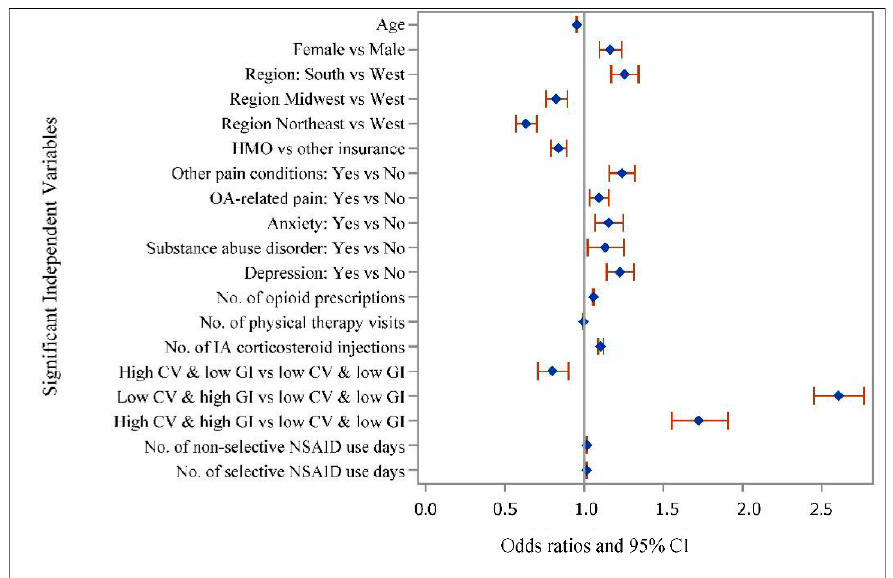
Figure 2. Unadjusted Odds Ratios and 95% CI for Potentially Inappropriate NSAIDs Use in Older Adults with Osteoarthritis. Note: Based on 44,990 older adults (age > 65) with OA using data from